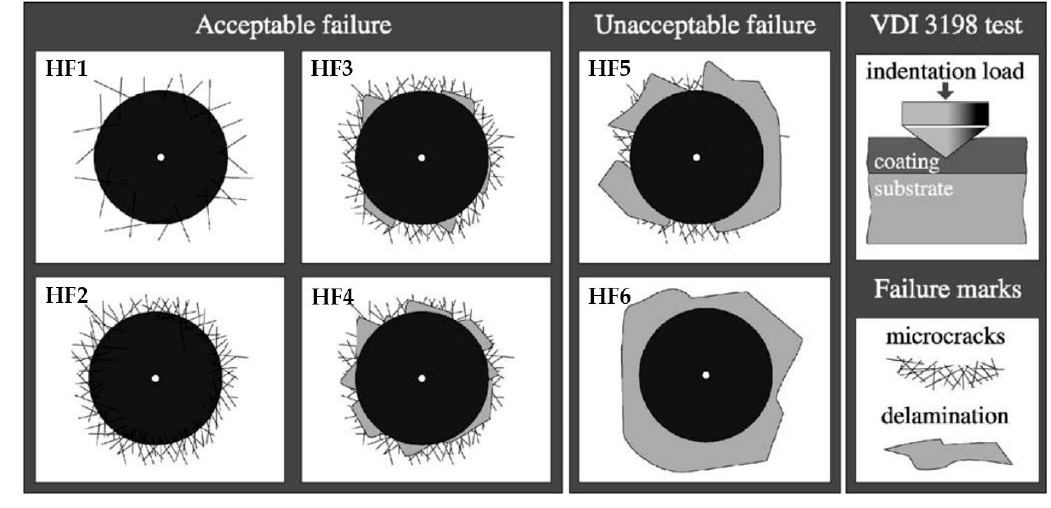
Figure 3. Chart VDI 3198 indentation test.